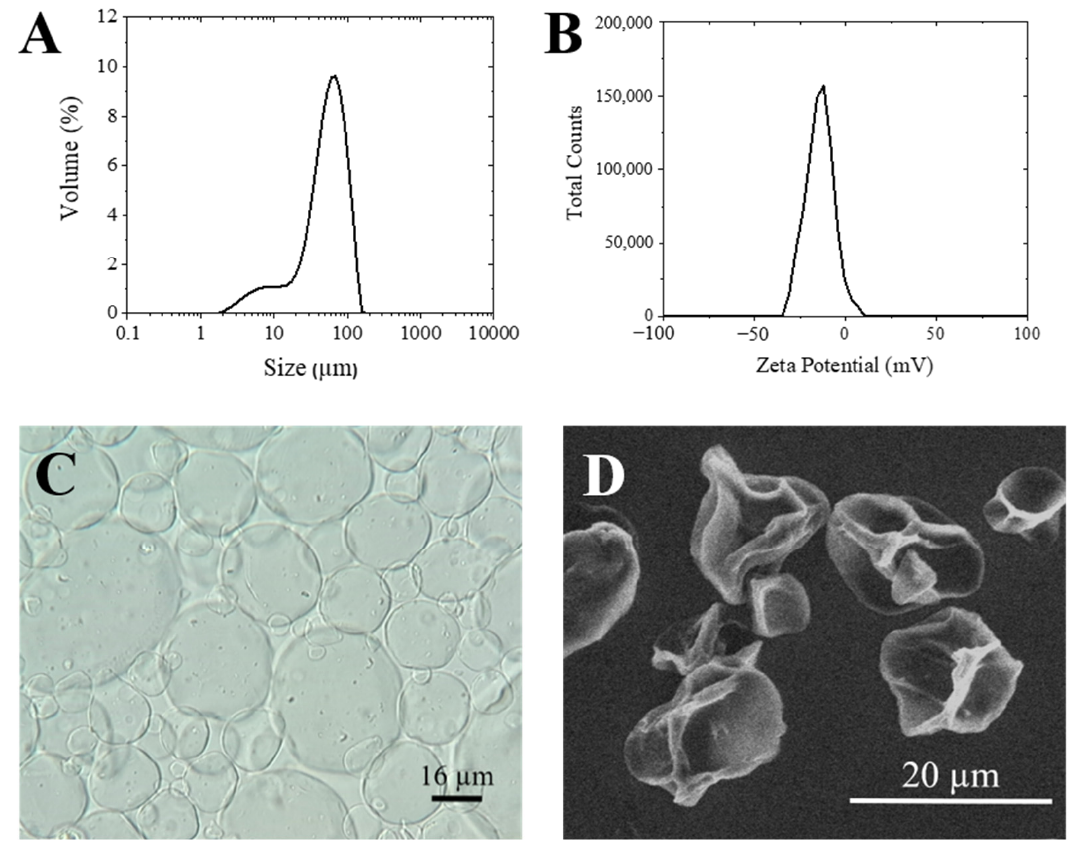
Figure 8. Morphological characterization of Alg-BaCl2 MPs. ( A ) size distribution by Mastersizer; ( B ) zeta potential by DLS; ( C ) optical microscope image; ( D ) ESEM image.